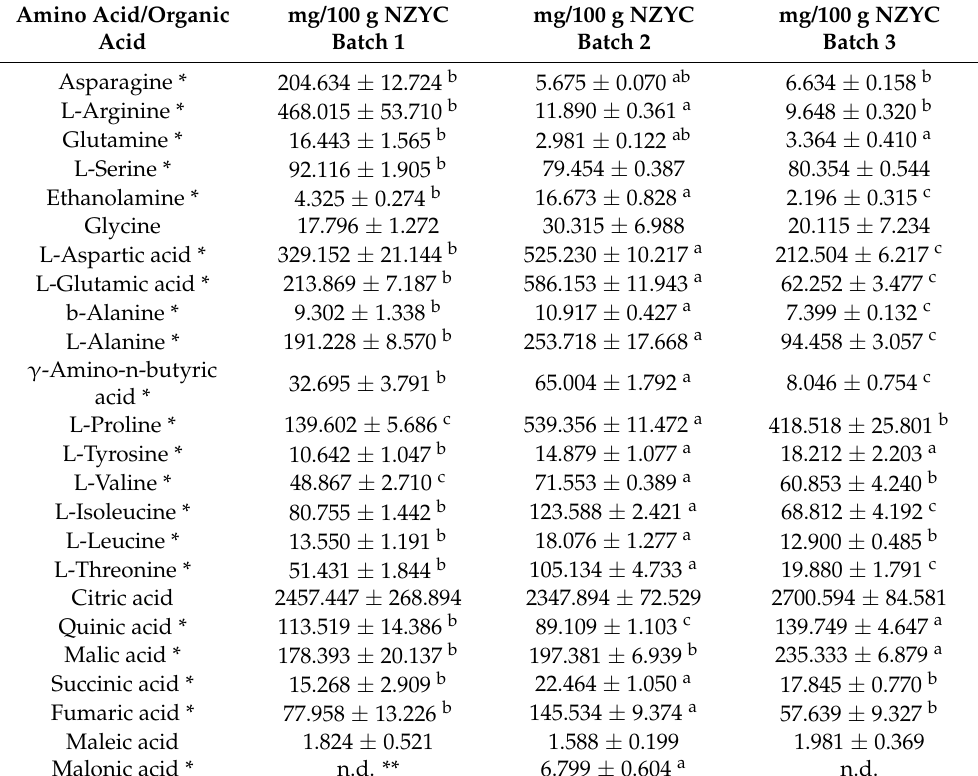
Table 6. Amino acid and organic acid profiles of NZYC ( n =